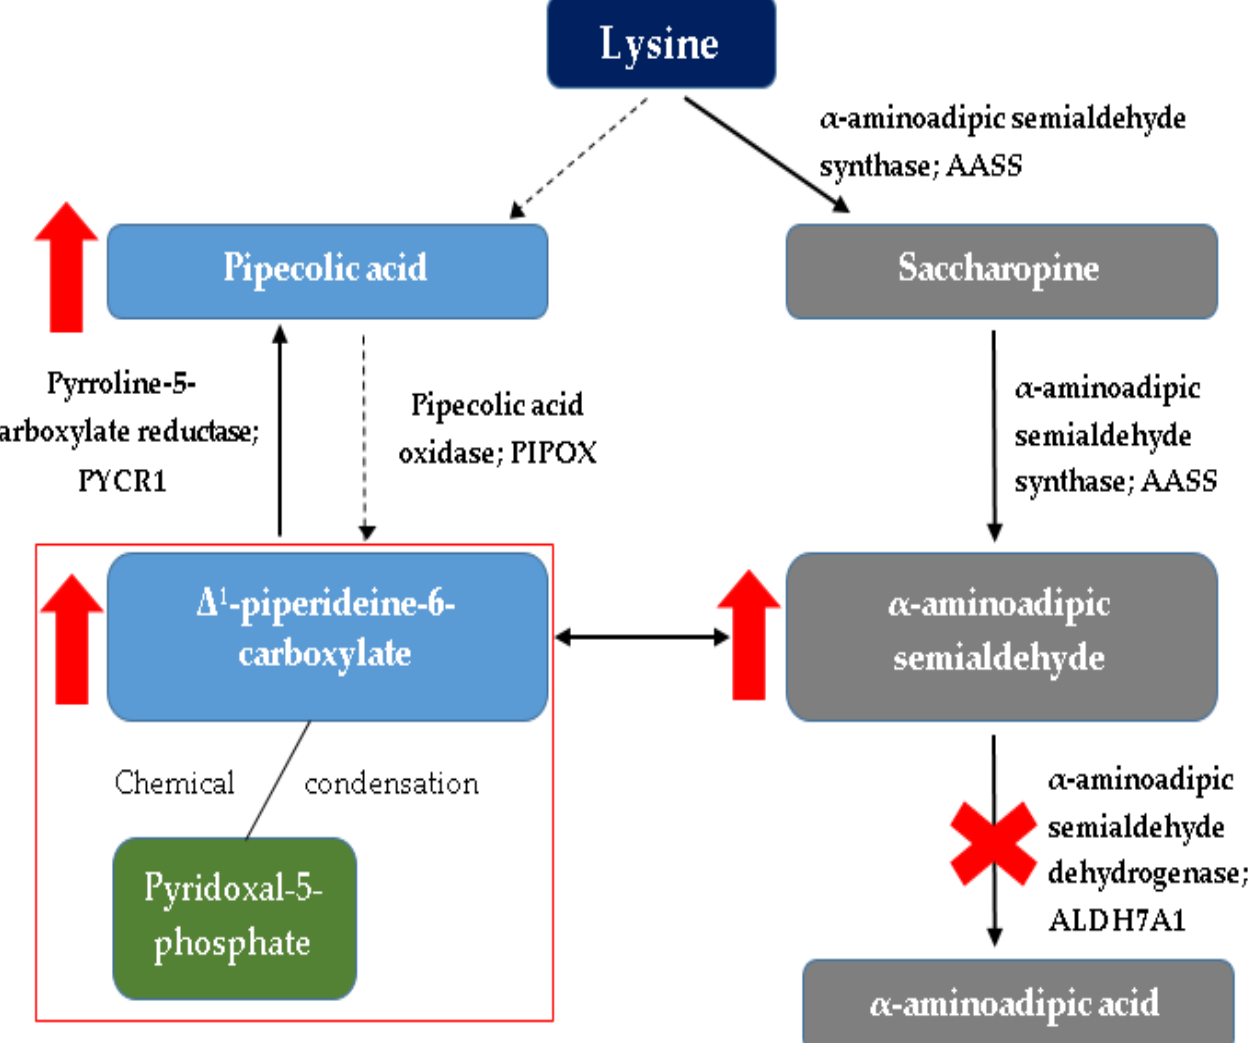
Figure 1. Simplified diagram of lysine metabolism with detailed (red markings) changes occurring in this cycle in pyridoxine-dependent epilepsy. The red rectangle indicates the main problem underlying the PDE, i.e., binding of the active form of vitamin B6 (pyridoxal-5-phosphate) by intermediate metabolites of lysine catabolism ( ∆ 1-piperideine-6-carboxylate) [1,2,16–19]. Seizures caused by hypoxic-ischemic encephalopathy (HIE), congenital central ner- vous system (CNS) malformations, other rare inborn errors of metabolism (IEM), genetic epilepsy syndromes, and those due to intracranial hemorrhage (ICH) or infection may not respond to vitamin B6 supplementation